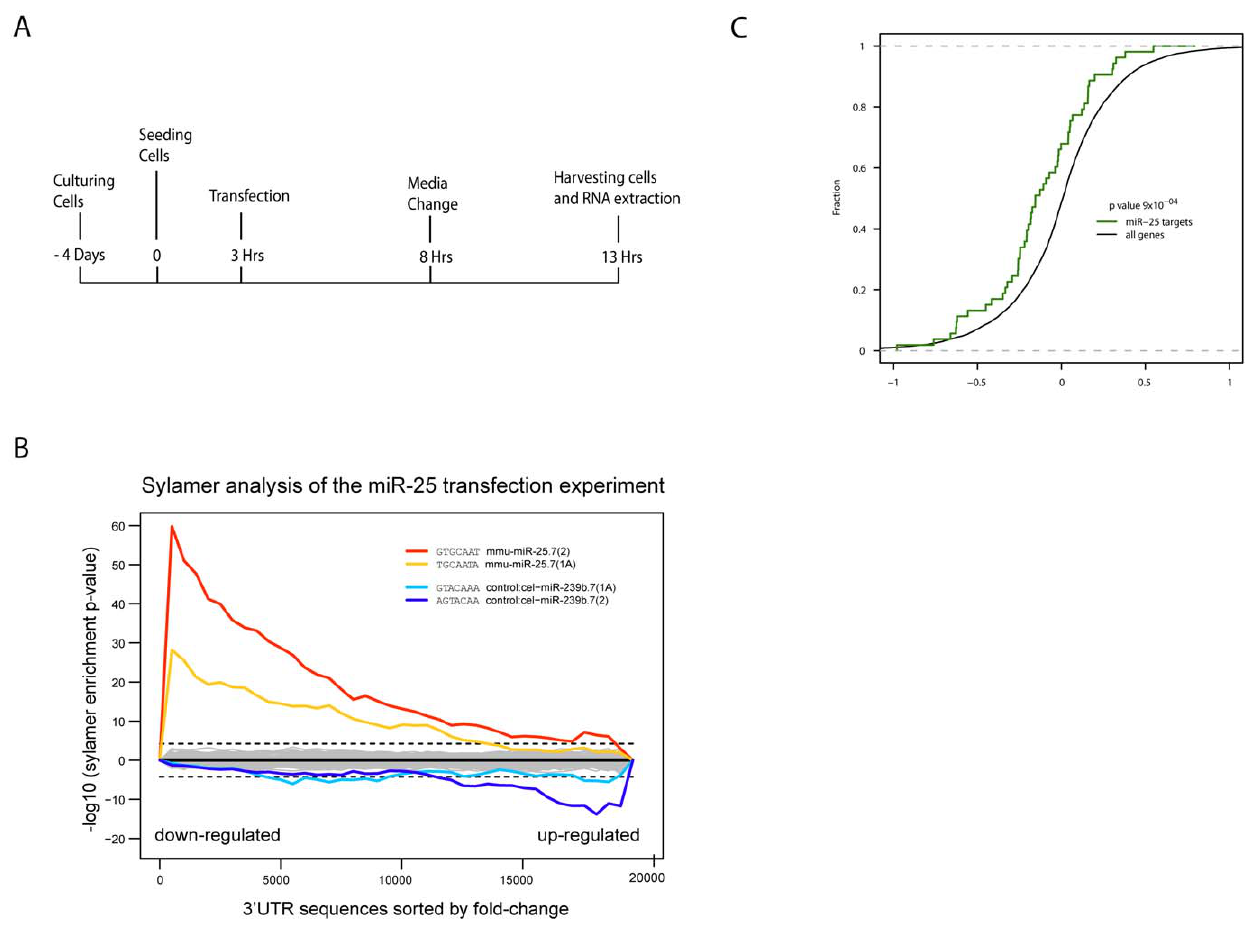
Figure 5. Identification of miR-25 targets. a. Timeline of miR-25 mimic transfection into the Dgcr8 -deficient ES cells for discovering transcripts that were repressed by miR-25. The C. elegans miRNA, cel-miR-239b, was used as the negative control. b. Sylamer plots following the analysis of microarray data. The x-axis represents the 3 9 UTR sequences of all transcripts, sorted from the most down-regulated after miR-25 transfection compared to the cel-miR-239b transfection. Sylamer was used to analyze the enrichment or depletion of all possible heptamers matching mouse miRNA seeds, at every 500 sequences of the gene list. The horizontal dashed lines denote Bonferroni corrected p-value thresholds of 0.05. Words matching the mmu-miR-25 and cel-miR-293b seeds are highlighted. c. Cumulative fraction plot of the fold-changes obtained by comparing 25-iPS vs 4F-iPS microarrays. The fold-changes for all genes are indicated by the black curve; the green curve represents the 54 miR-25 targets from Table S4.